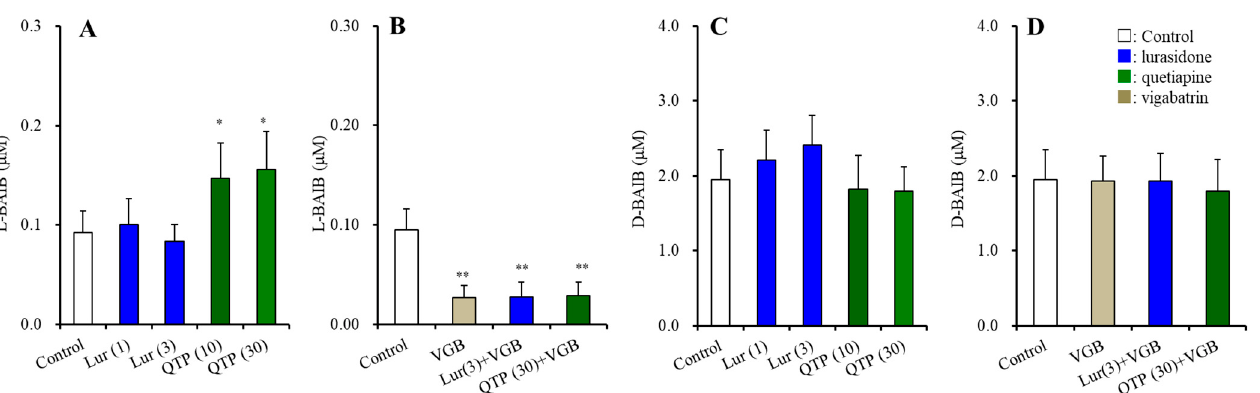
Figure 2. Effects of chronic administration of lurasidone (Lur: 1 and 3 mg/kg/day for 14 d), quetiapine (QTP: 10 and 30 mg/kg/day for 14 d), and chronic co-administration of vigabatrin (VGB: 75 mg/kg/day) with lurasidone (3 mg/kg/day) or quetiapine (30 mg/kg/day) for 14 d on plasma levels of BAIBA enantiomers, L-BAIBA ( A , B ) and D-BAIBA ( C , D ). Ordinate: mean ± SD ( n = 6) of plasma levels of BAIBA enantiomers (µM). *: p < 0.05, **: p < 0.01: relative to control (vehicle alone: MRS containing 0.1% DMSO) by ANOVA with Tukey’s post hoc test.